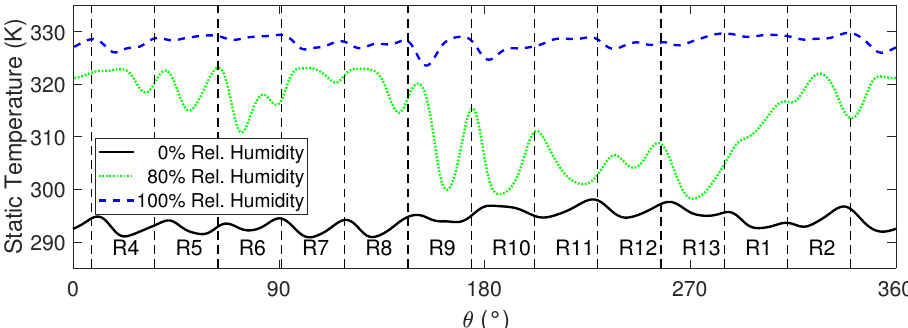
Figure 11. Circumferential plot of the static temperature for three different relative humidities at the turbine outlet at 50% span. Adapted from [12]. Copyright 2022